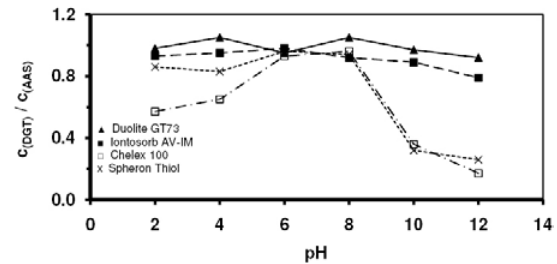
Figure 2. Influence of pH to measurement of mercury by DGT technique with various sorption gels